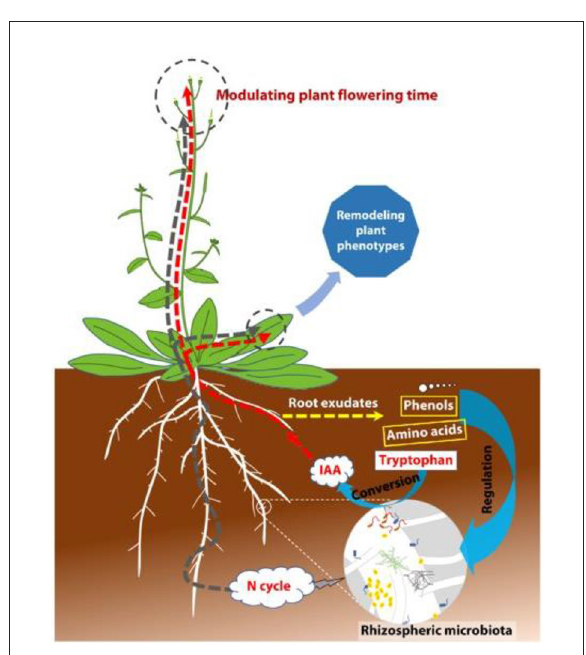
FIGURE2 Rhizospheric interactions between the environment, microbes, and plants. Adapted from Lu et al.